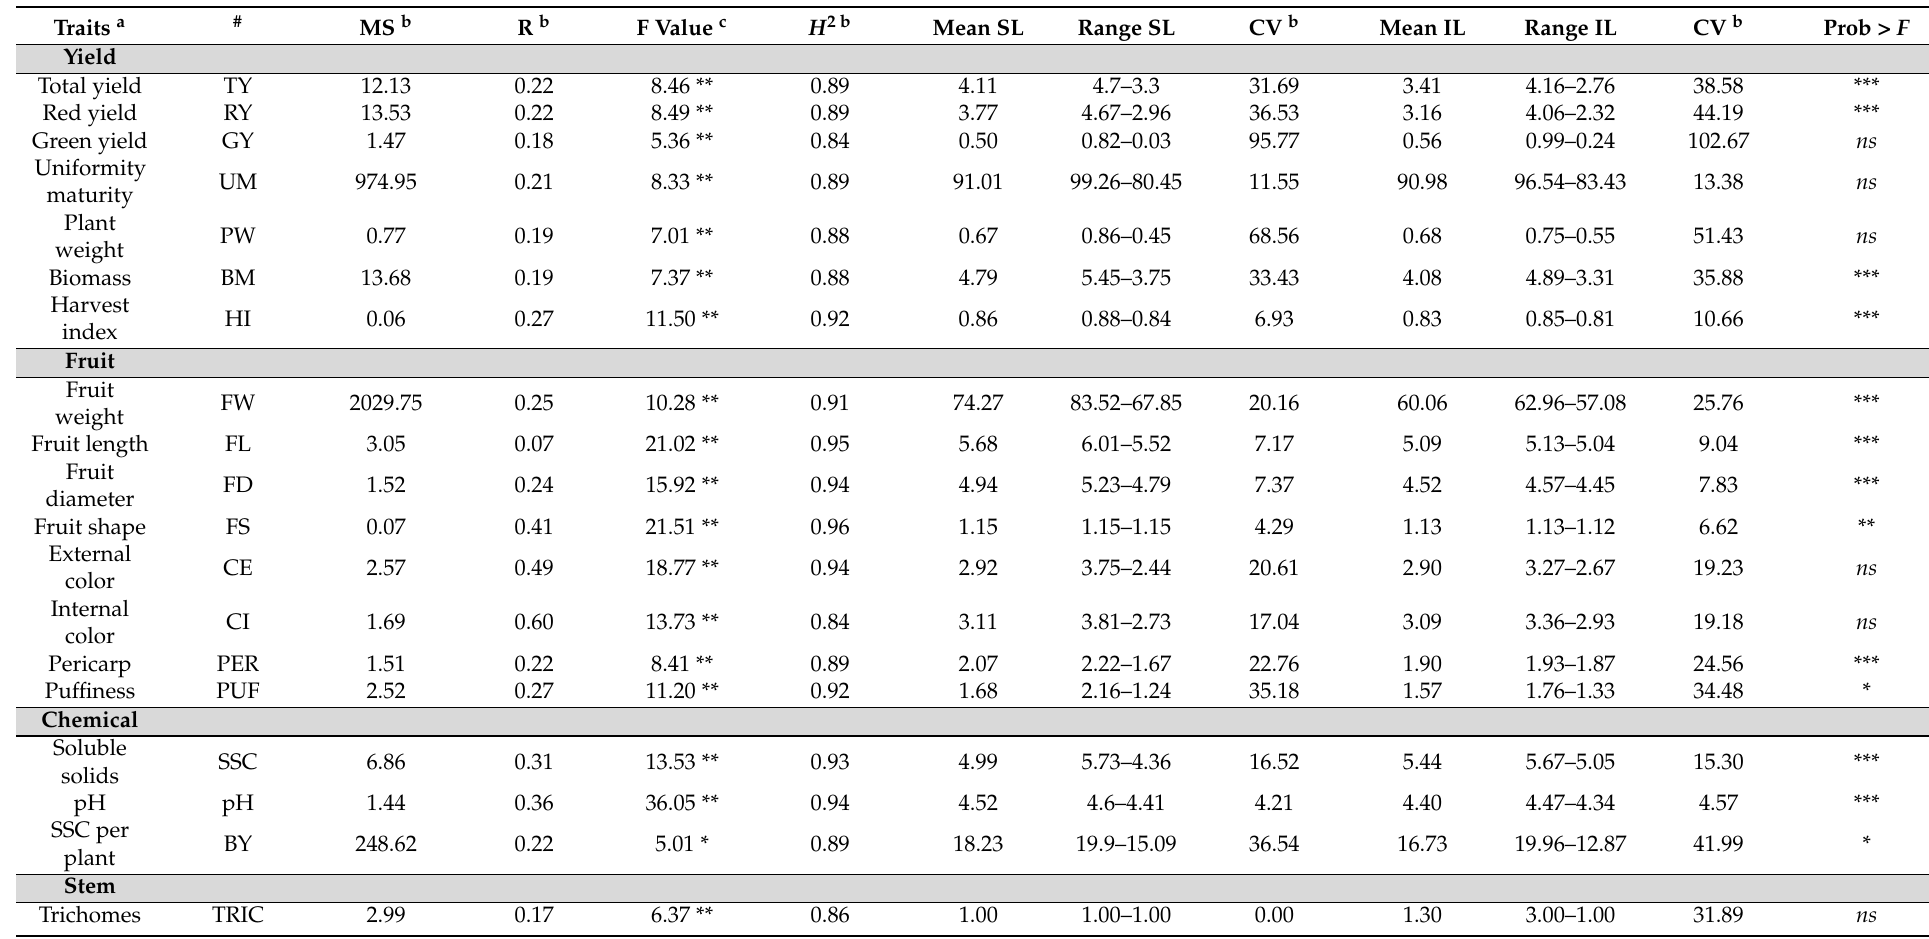
Table 3. Descriptive statistics of the traits analyzed in the 39 introgression lines (IL) and the control (SL) during three consecutive growing seasons. Traits